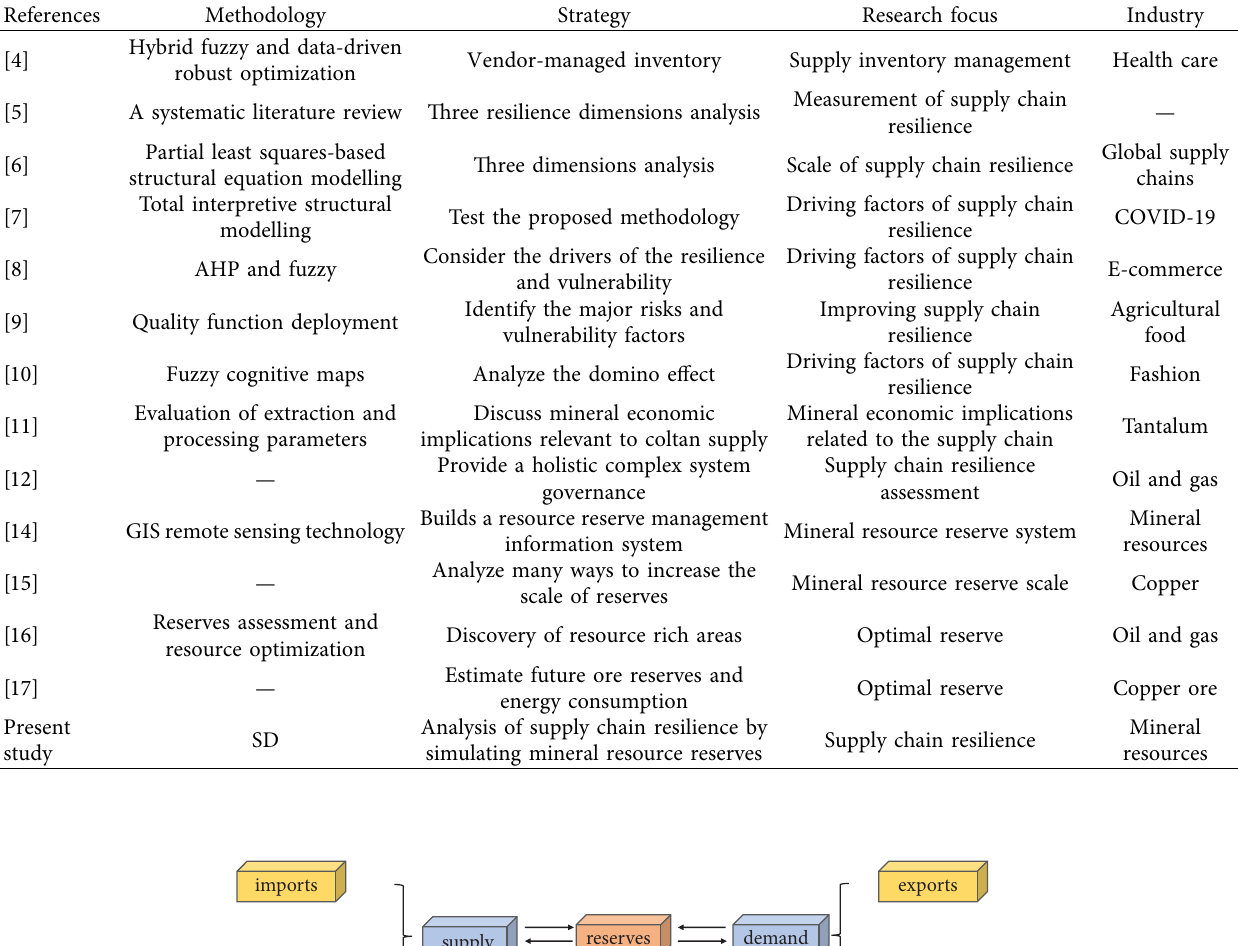
Table 1: Survey of supply chain resilience and mineral resource reserves.